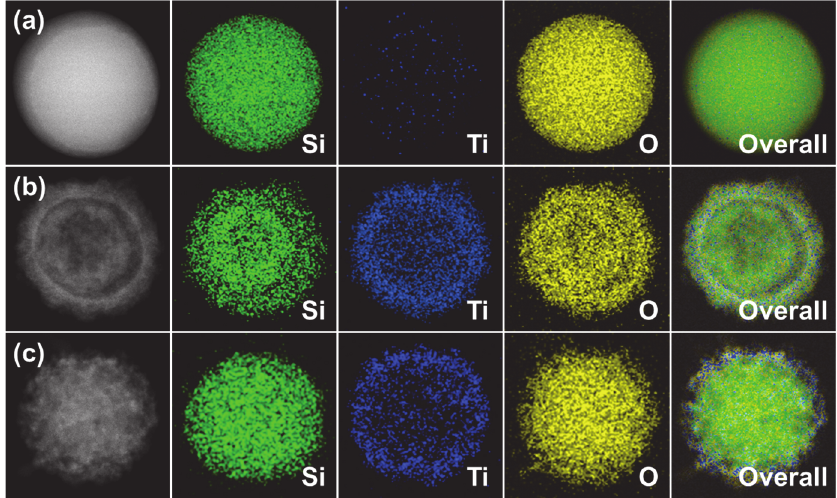
Figure 9. HAADF-STEM images and the corresponding elemental mapping images of ( a ) 100 nm SiO 2 nanoparticles, ( b ) 130 nm ST CSNs, and ( c ) 140 nm SBT CSNs displaying the presence of Si (green), Ti (blue), and O (yellow) elements. Overall images were acquired by superimposing HADDF and each elemental image.